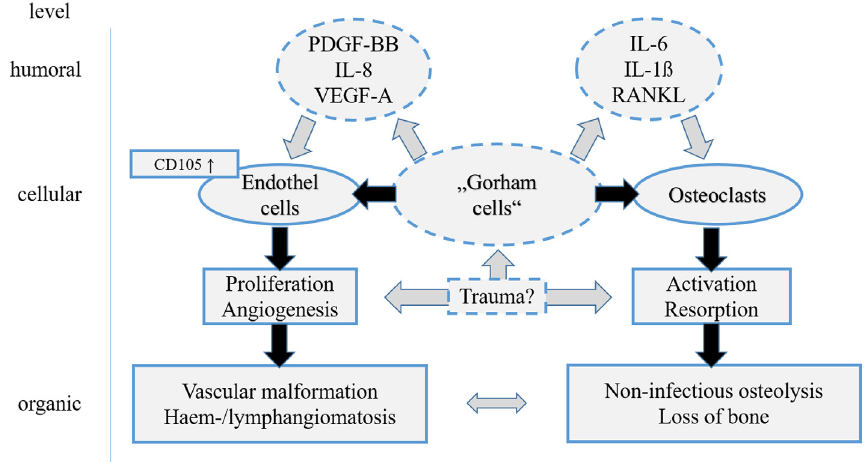
Figure 5. Overview of the existing theories regarding pathomechanism in Gorham-Stout syndrome. Broken lines and grey arrows show theoretical considerations still lacking proof. Role of trauma still remains uncertain. Elevated levels of Il-6 and differentiation factors Il-1 b and RANKL may stimulate osteoclasts and lead to bone resorption while PDGF-BB, IL-8 , and VEGF-A may activate endothelial cells and others via CD105 and TGF-beta1-receptor . This may result in vascular malformation and lymphangiomatosis. Both are characteristics of Gorham-Stout